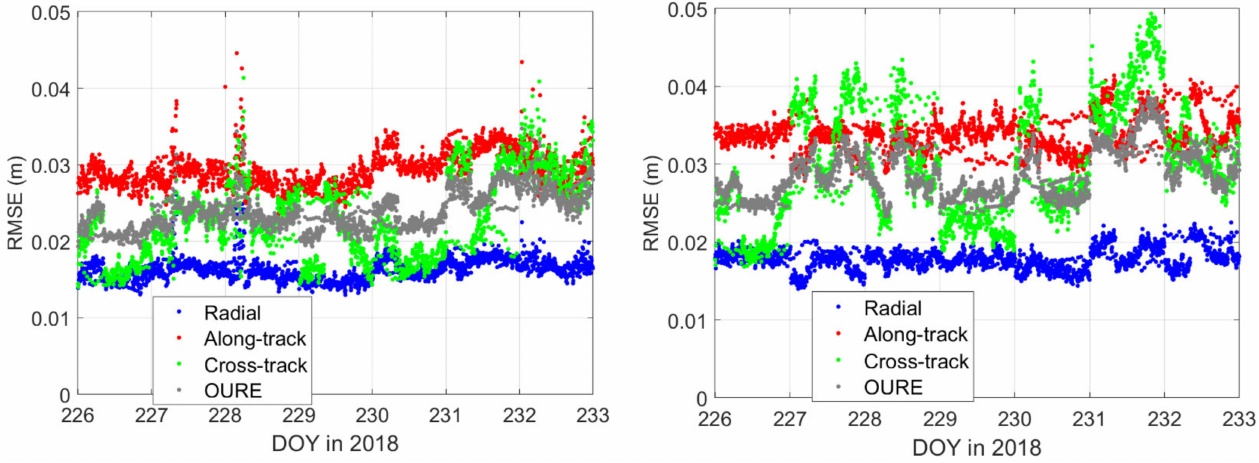
Figure 4. RMS and σ OURE of the 24 h BLS orbital errors for Sentinel-3B using time intervals shifted from 14 to 20 August 2018. ( Left ) the CNES real-time products and ( right ) the IGS RTS products were used for the